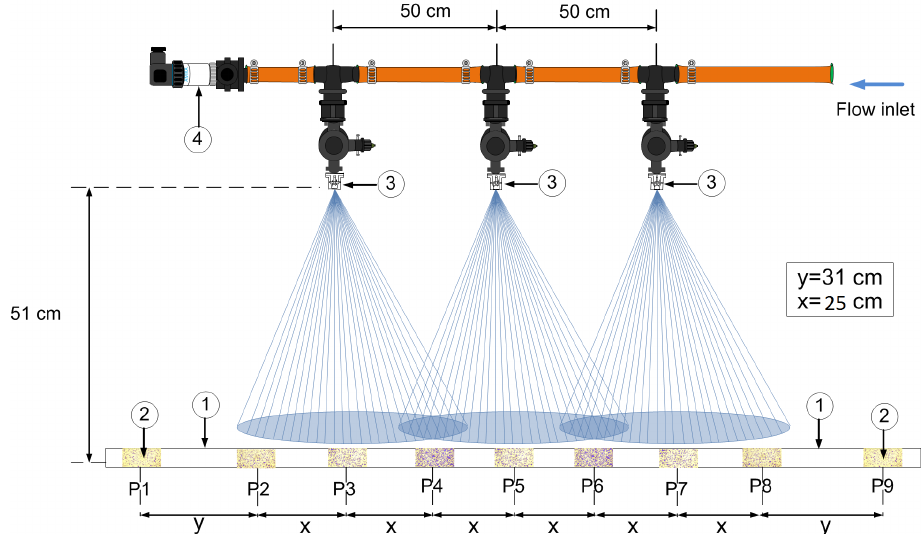
Figure 6. Magnified view of the spray boom with the nozzles used for data collection with (1) an aluminum bar with an impermeable paint coating, (2) water-sensitive papers, (3) a set of nozzles, and (4) a pressure